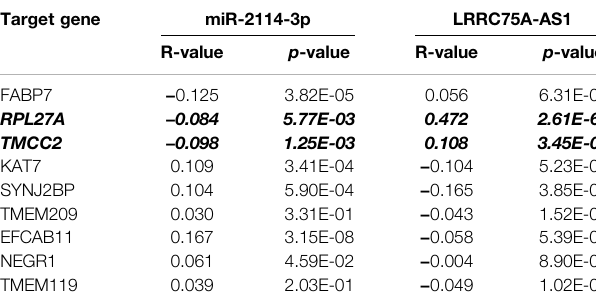
TABLE 4 | The expression correlation of miR-2114-3p with target genes or target genes with LRRC75A-AS1 in breast